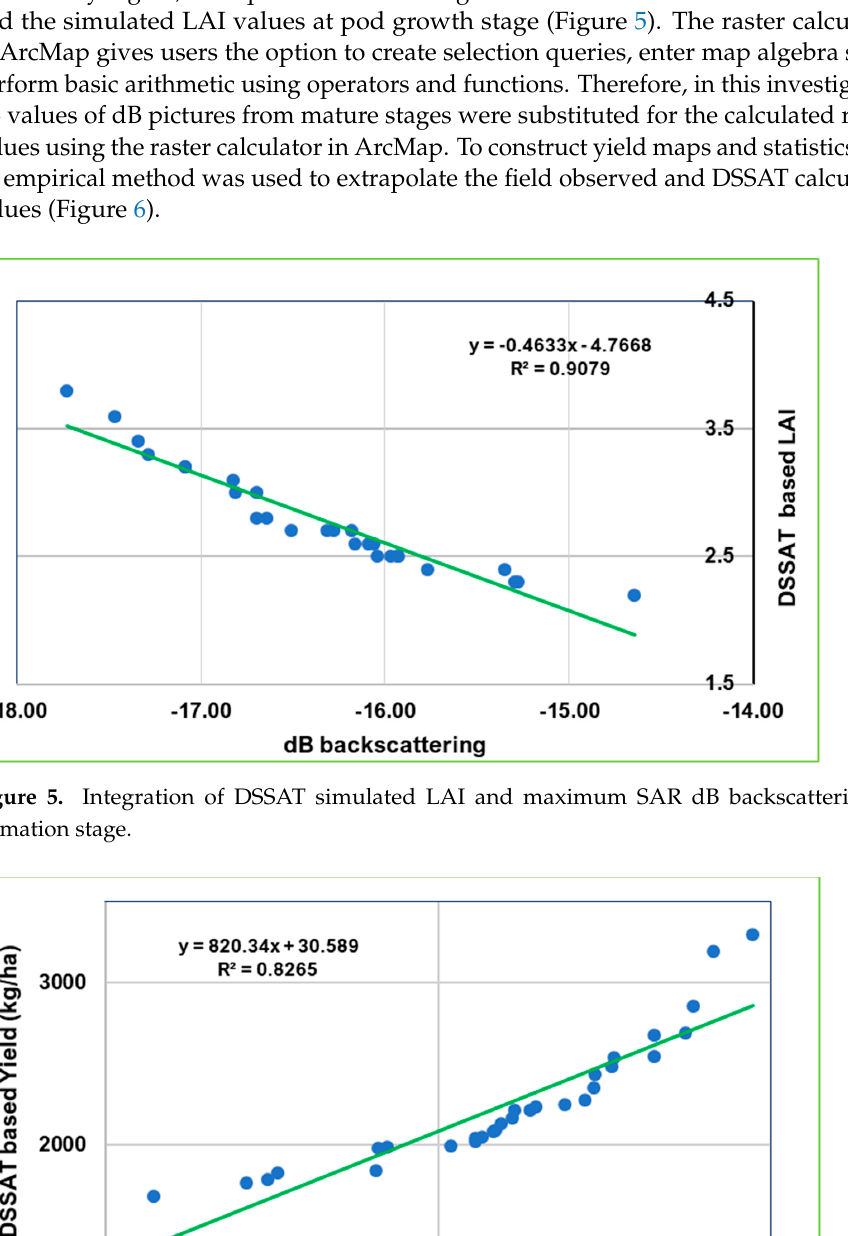
Figure 6. Integration of SAR derived LAI and DSSAT simulated yield for the estimation of spatial variability.